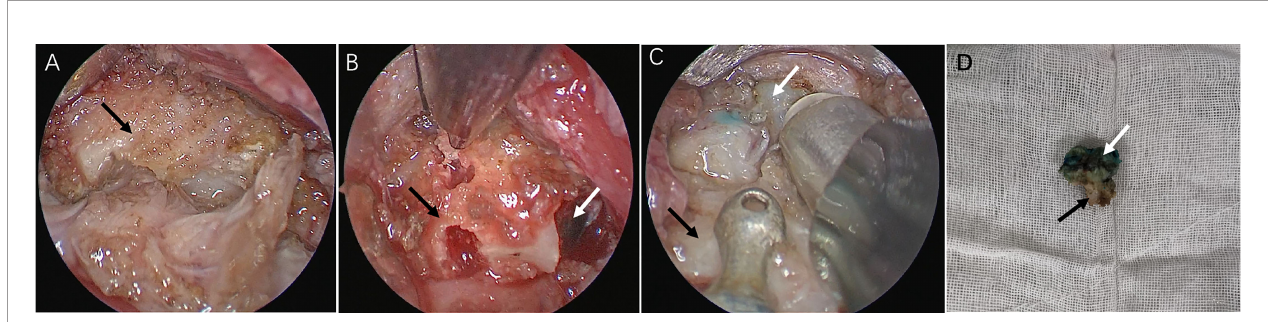
FIGURE 3 | (A) Identi fi cation of hyoid bone (black arrow). (B) Identi fi cation of TGDC (white arrow). (C) Dissection of the cyst. (D)